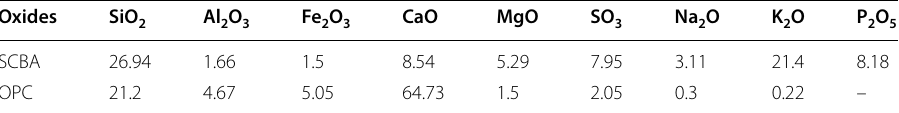
Table 1 Chemical composition of SCBA and OPC Oxides